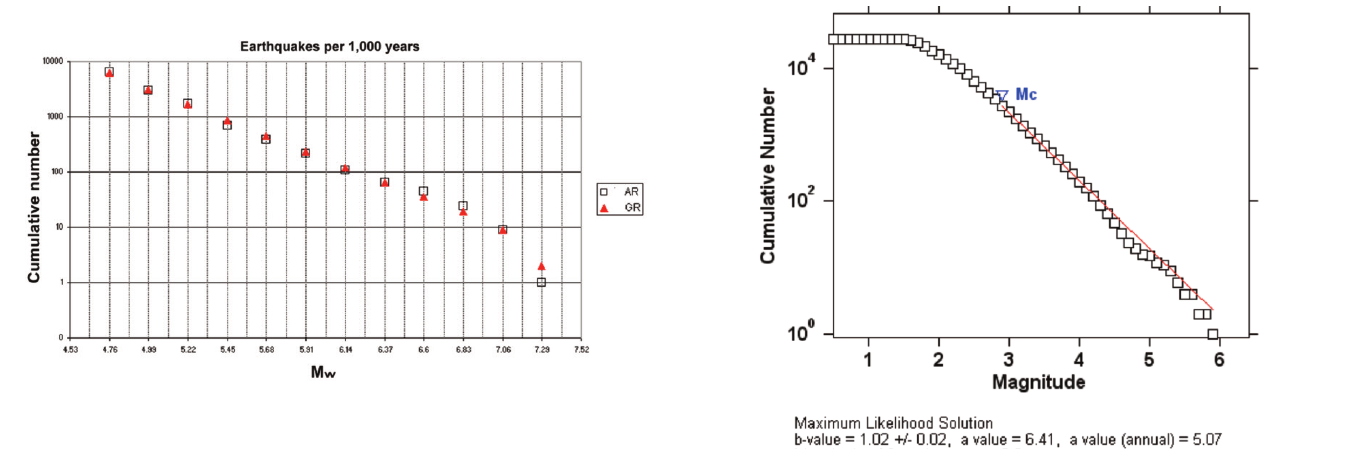
≥ 4.76 calculated using activity rates (AR) and straight Gutenberg-Richter (GR) law by MSP04 Figure 3 (left). Cumulative number of earthquakes with M w [see MSP Working Group 2004, for details]. Figure 4 (right). Cumulative number of events per year versus magnitude from the CSI 1.1 declustered